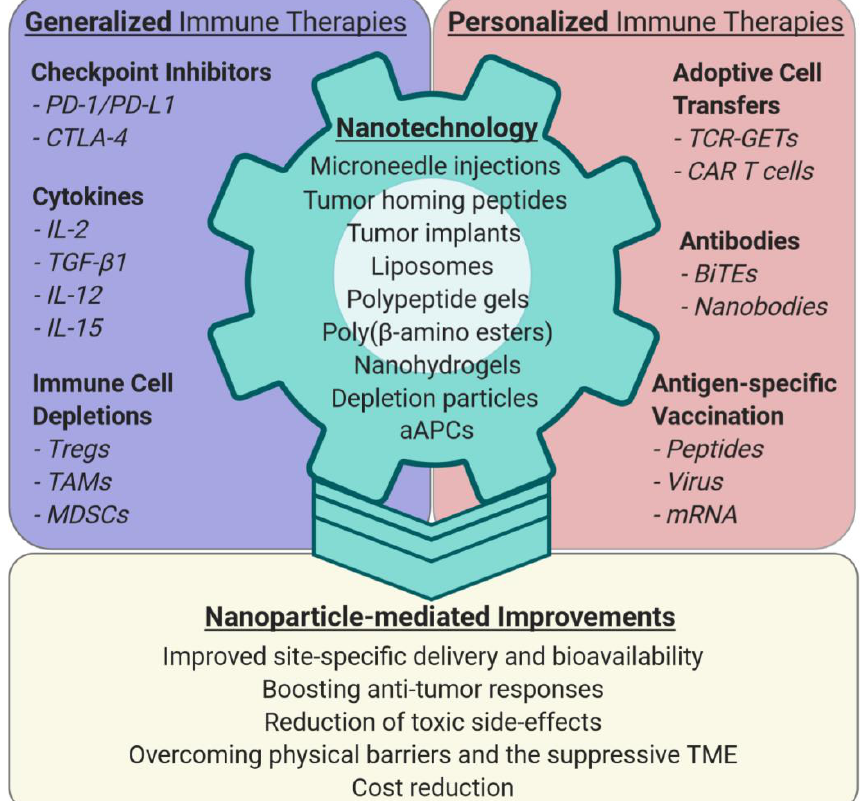
Figure 1. Nanotechnology to improve general and personalized cancer immunotherapies . Nanoparticles can guide given therapeutic agents to specific sites in the body via systemic application, tumor implants, microneedle injection, or tumor homing peptides to improve their bioavailability and stability. Nanomaterials with in vivo efficacy and tolerability are, for example, liposomes, polypeptide gels, poly-β-amino esters, nanohydrogels, or guided aAPCs (artificial antigen presenting cells). They can be engineered to deplete or inhibit immune cell subtypes. Nanoparticle-enhanced efficacy of immune therapies can result in better anti-tumor responses, reduction of systemic toxicities, and cost reduction, because lower amounts of expensive immunotherapeutic agents are needed to achieve a comparable or superior therapeutic effect. Moreover, nanoparticle-mediated targeting of immune suppressive cell types in the TME (tumor microenvironment), especially myeloid cells (TAMs, MDSCs), can make solid tumors more accessible to T- and cancer cell-directed immunotherapy. Abbreviations: programmed cell death protein 1 (PD-1), programmed cell death 1 ligand 1 (PD-L1), cytotoxic T-lymphocyte-associated protein 4 (CTLA-4), interleukins (IL), regulatory T cell (Treg), tumor associated macrophage (TAM), myeloid-derived suppressor cell (MDSC), T cell receptor genetically engineered T cells (TCR-GETs), chimeric antigen receptor (CAR), artificial antigen presenting cell (aAPC).